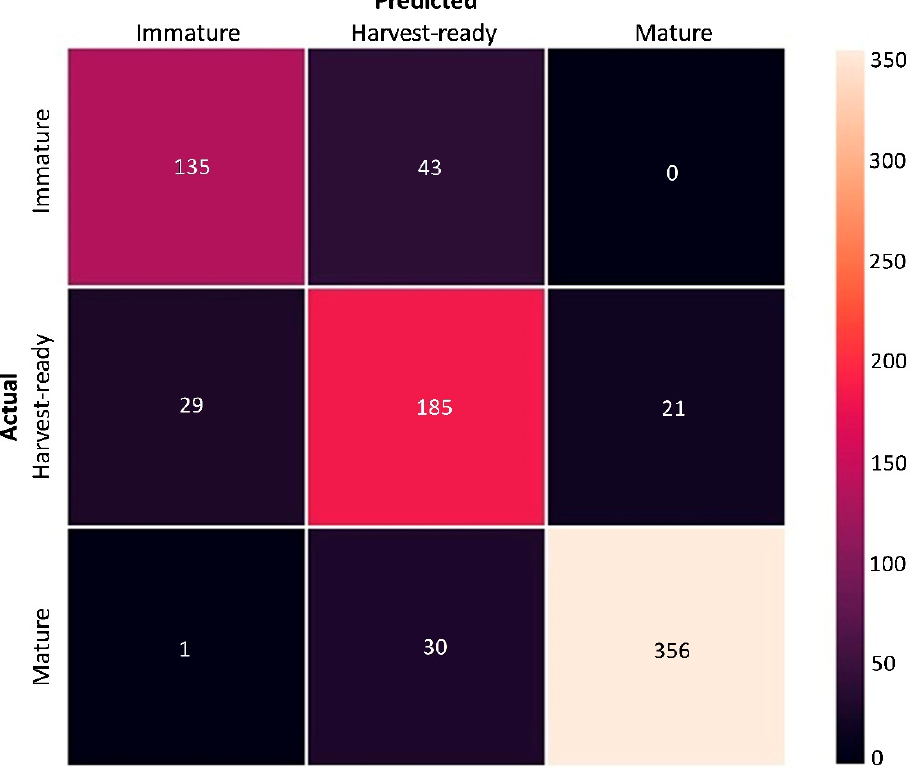
Figure 5. Confusion matrix of actual and predicted maturity classes generated after a linear discriminant analysis of the fluorescence spectra obtained from fruit of the four peach cultivars ‘August Flame’, ‘O’Henry’, ‘Redhaven’ and ‘September Sun’ pooled together ( n = 800). Numbers in each cell represent fruit counts for a specific predicted-actual combination. Numbers in the diagonal top-left to bottom-right axis represent true positives of the prediction.